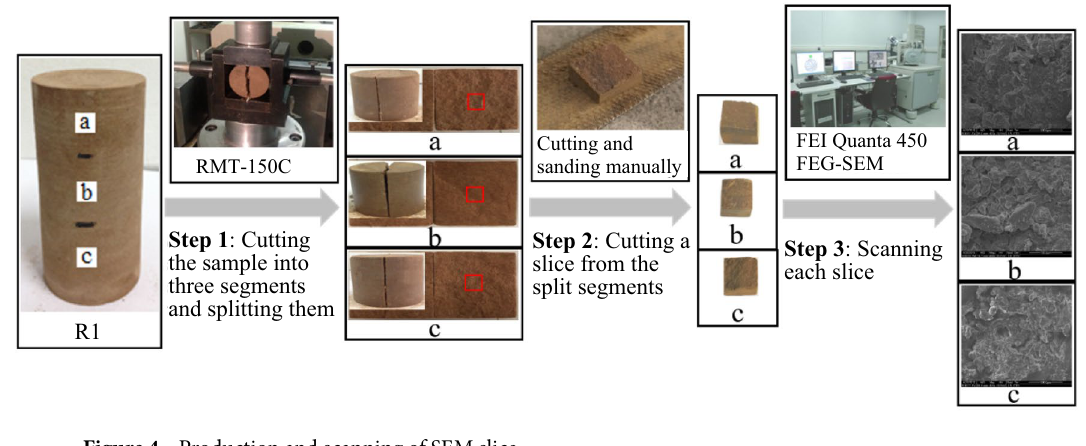
Figure 4. Production and scanning of SEM slice.